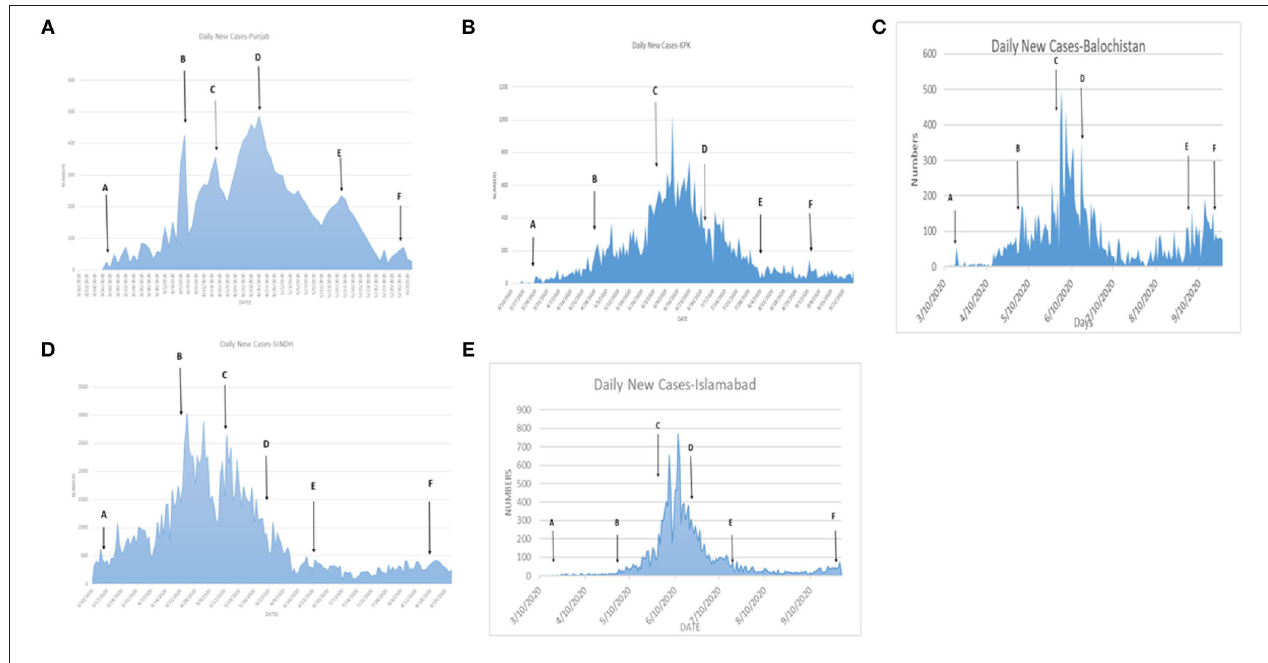
FIGURE 7 | (A–E) The number of cases in all provinces of Pakistan.